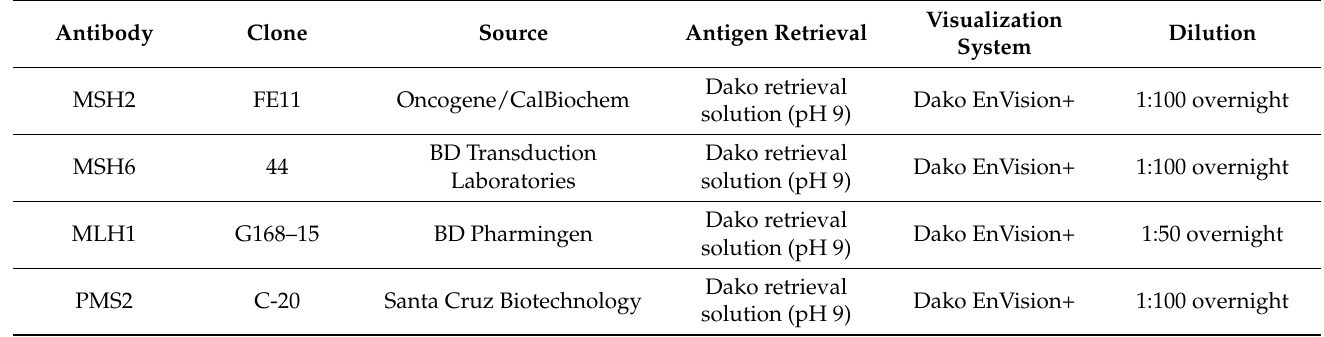
Table 5. Antibodies used for the mismatch-repair immunohistochemistry